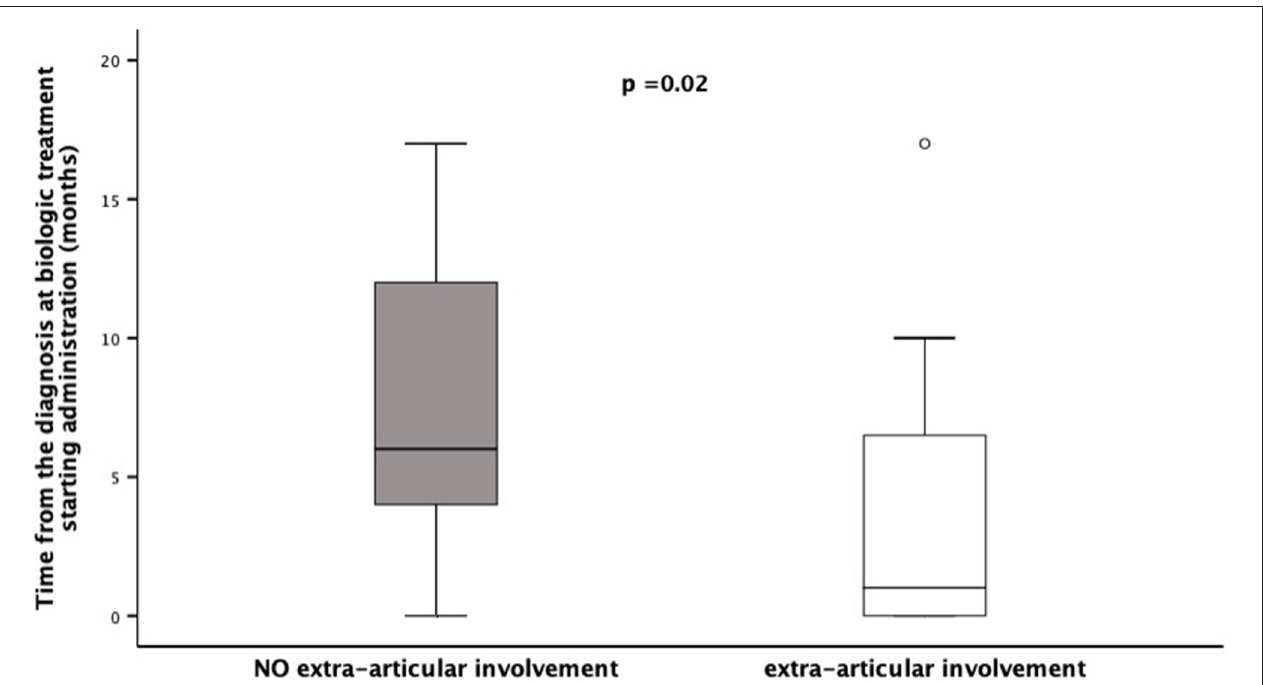
FIGURE 1 | Time of Biologic Treatment starting in a cohort of 53 children diagnosed as ERA-JIA at the onset of disease. Figure shows the time from the diagnosis at biologic treatment starting administration (months) in 12 children with extra-articular involvement, diagnosed ERA-JIA at the onset (white box) and in 21 ERA-JIA children without extra-articular manifestations (gray box). The central line represents the distribution median, boxes span 25th to 75th percentiles, and error bars extend from 10th to 90th percentiles. Dots are values higher than the 90th percentile. ( p = 0.002). ERA-JIA, enthesitis-related arthritis juvenile idiopathic